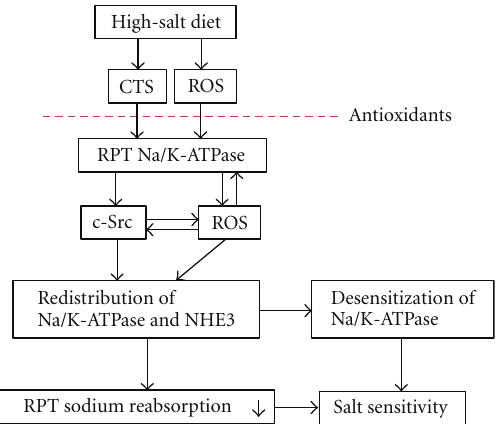
Figure 2: Schematic illustration of the e ff ects of ROS and Na/K- ATPase signaling on RPT sodium reabsorption. CTS: cardiotonic steroids; RPT: renal proximal